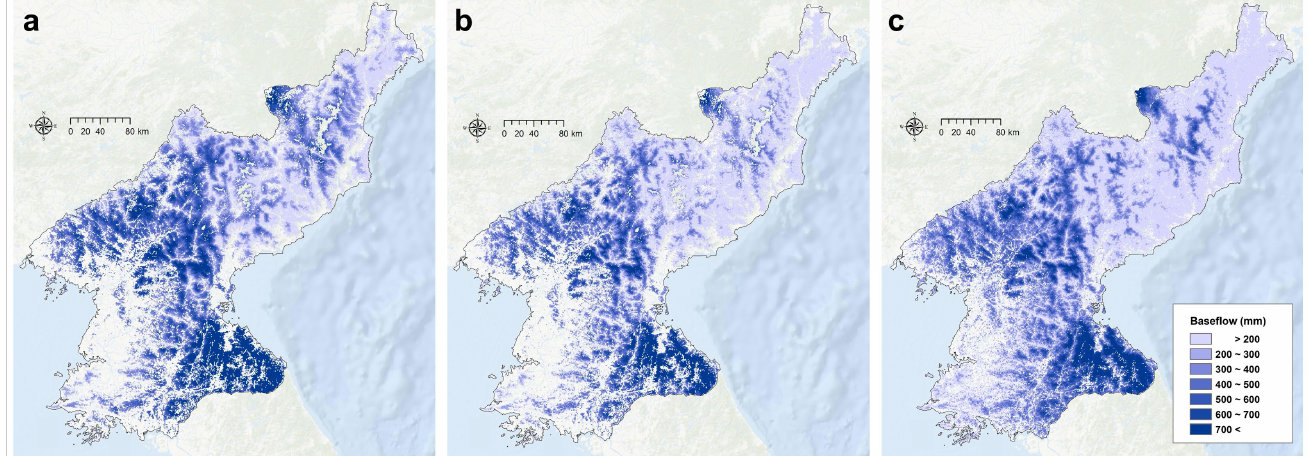
Figure 3. Spatial distribution of local recharge (L) in the forest area: ( a ) baseline period (1981–2010),